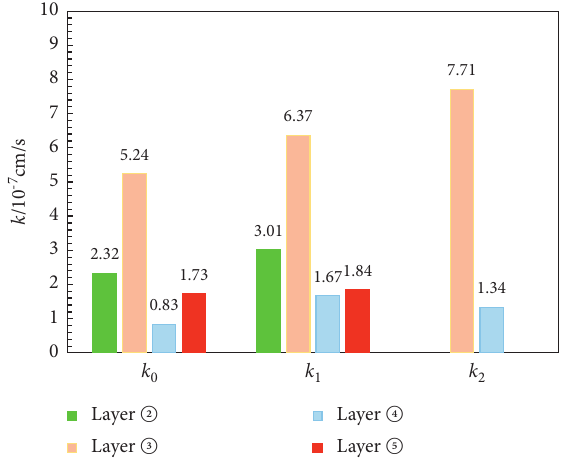
Figure 7: Correlation diagram of permeability coefficient between contaminated and uncontaminated clay. Table 9: Changes of clay porosity between TCE contaminated soils and uncontaminated